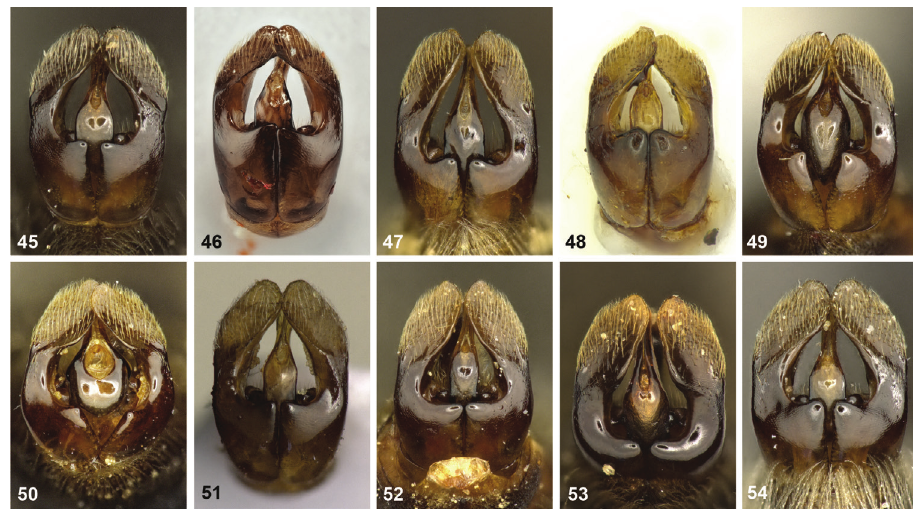
Other material: numerous specimens, only some of which are listed in Suppl. material 2: Table